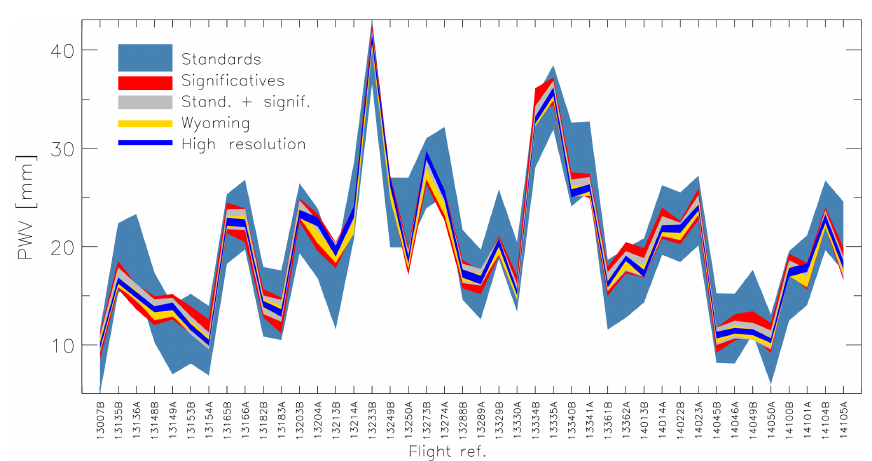
Figure 8. Comparison between the PWV series and errors (shadow) obtained from the GUI data with high-resolution radiosoundings ( > 2500 levels) and different sub-extractions of the same profiles. The colour code, from the less to the most sampled series, is in the legend. The labels in the x axis are the references for each balloon flight (see Table